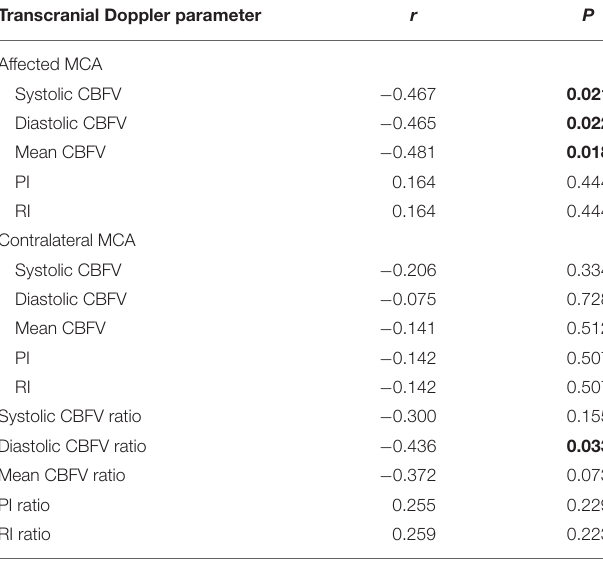
TABLE 4 | Correlation between transcranial Doppler parameters and severity of midline shift in patients with CED-3 ( n = 24). Transcranial Doppler